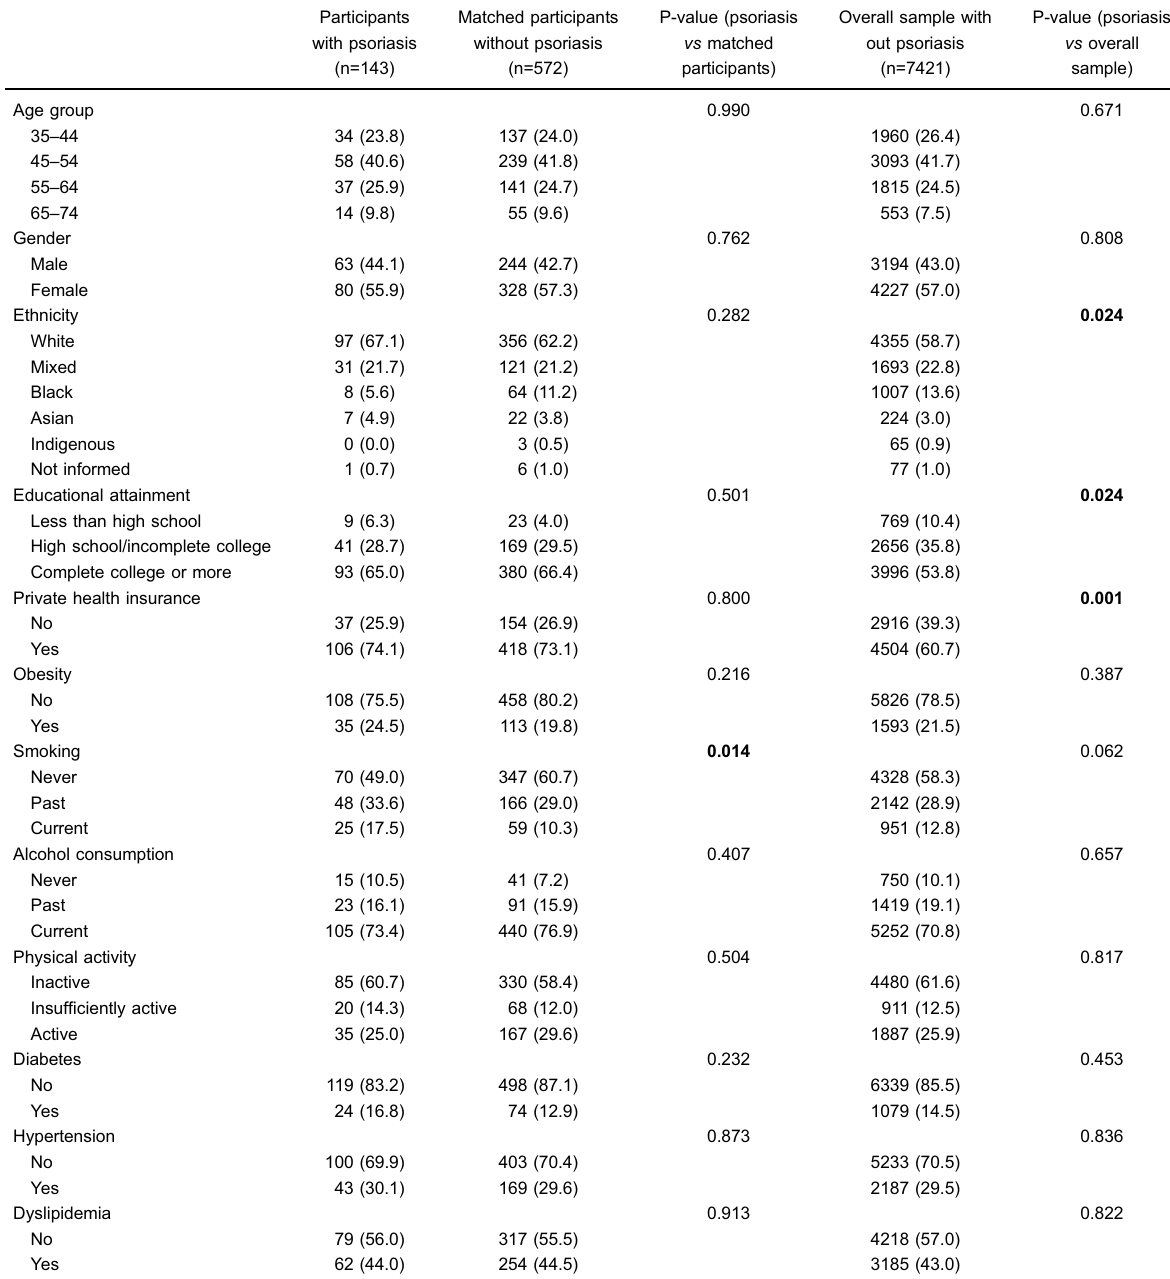
Table 1. Baseline characteristics of the